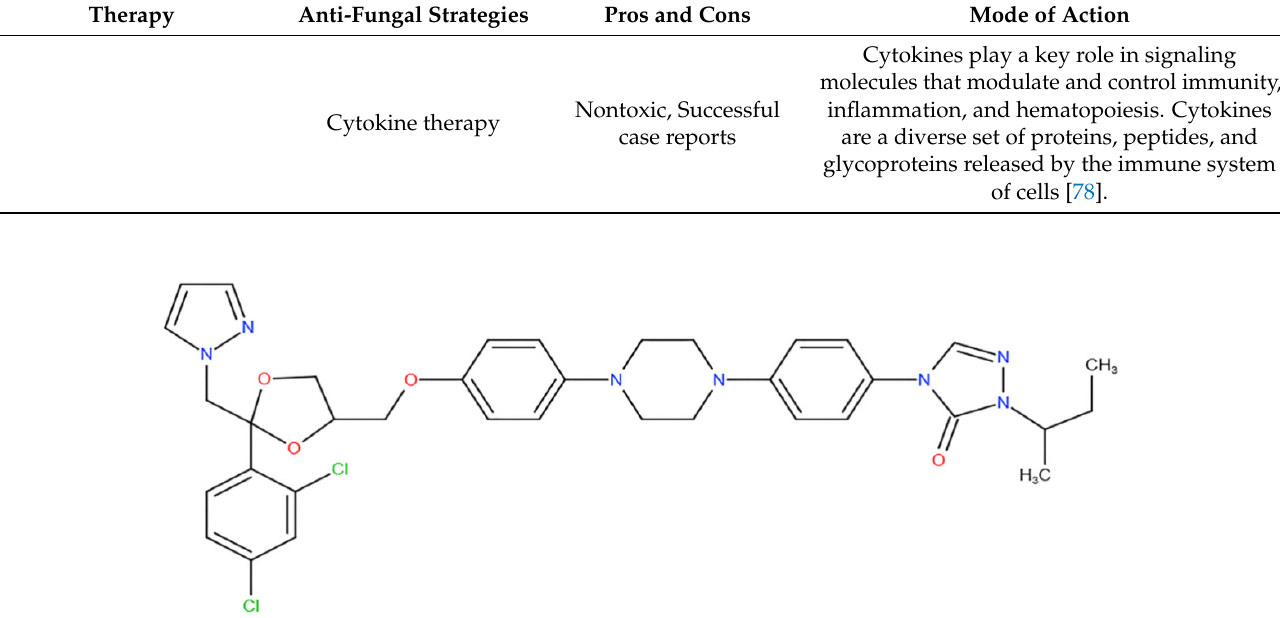
Figure 7. Chemical structure representing Itraconazole.